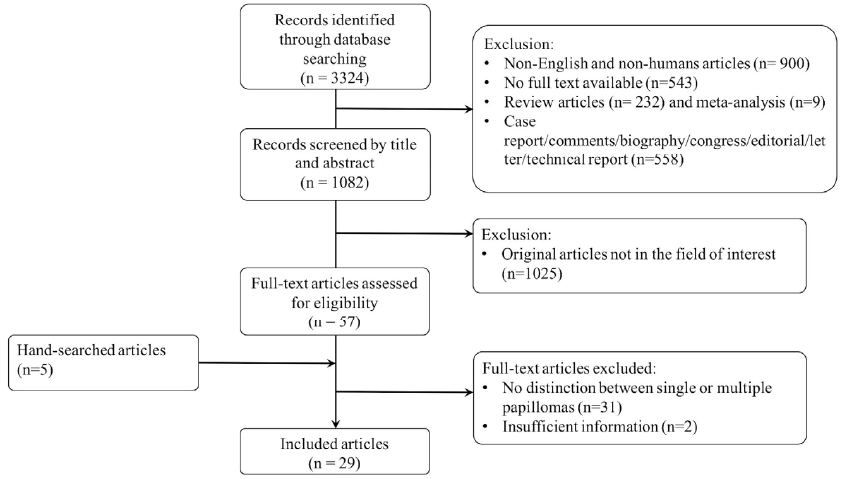
Figure 1. Flowchart of the selection of